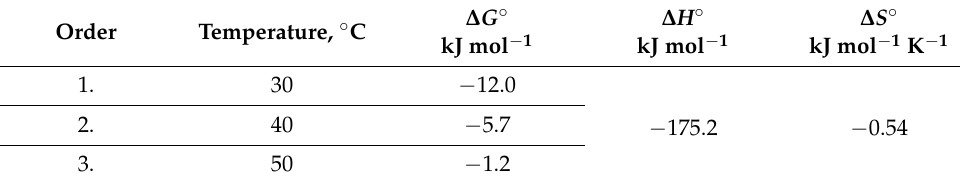
Table 3. Thermodynamic studies of CR adsorption onto Cu-ZnBO-Cp-CT **.